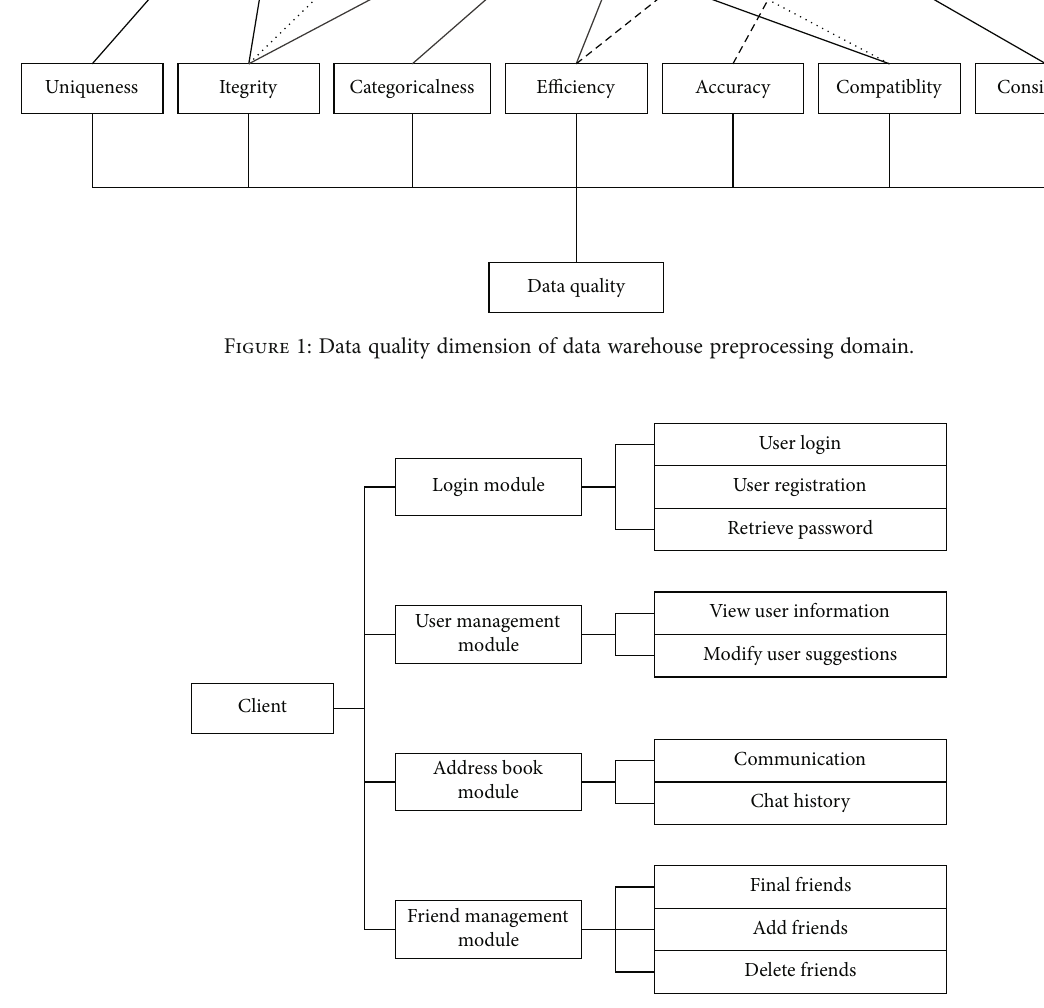
Figure 2: Client connection structure